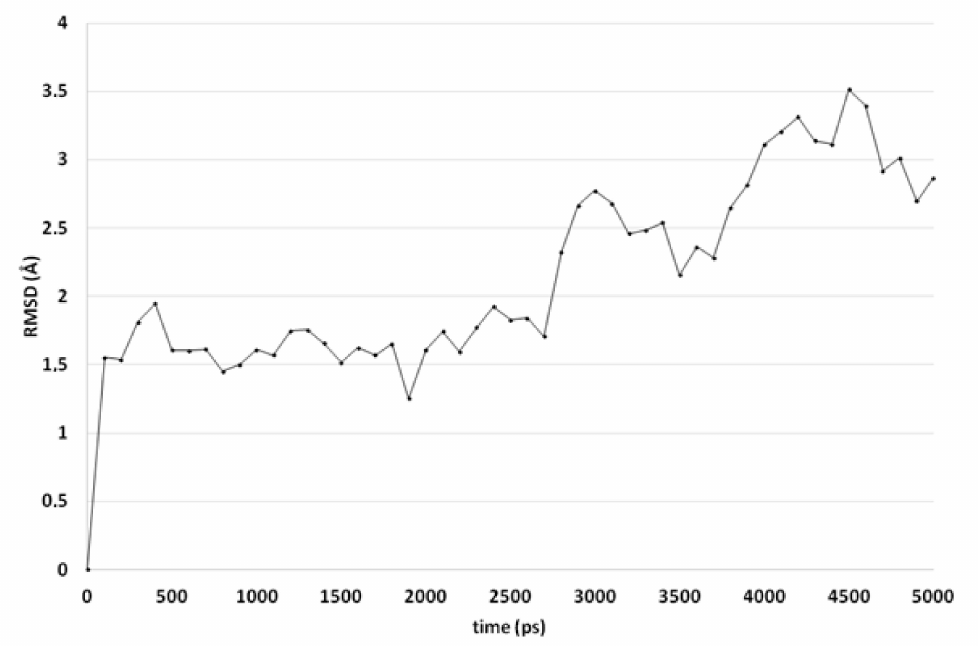
Figure 5. The RMSD of the ligand heavy atoms during the 5-ns molecular dynamics simulation of compound 4h in the active site of